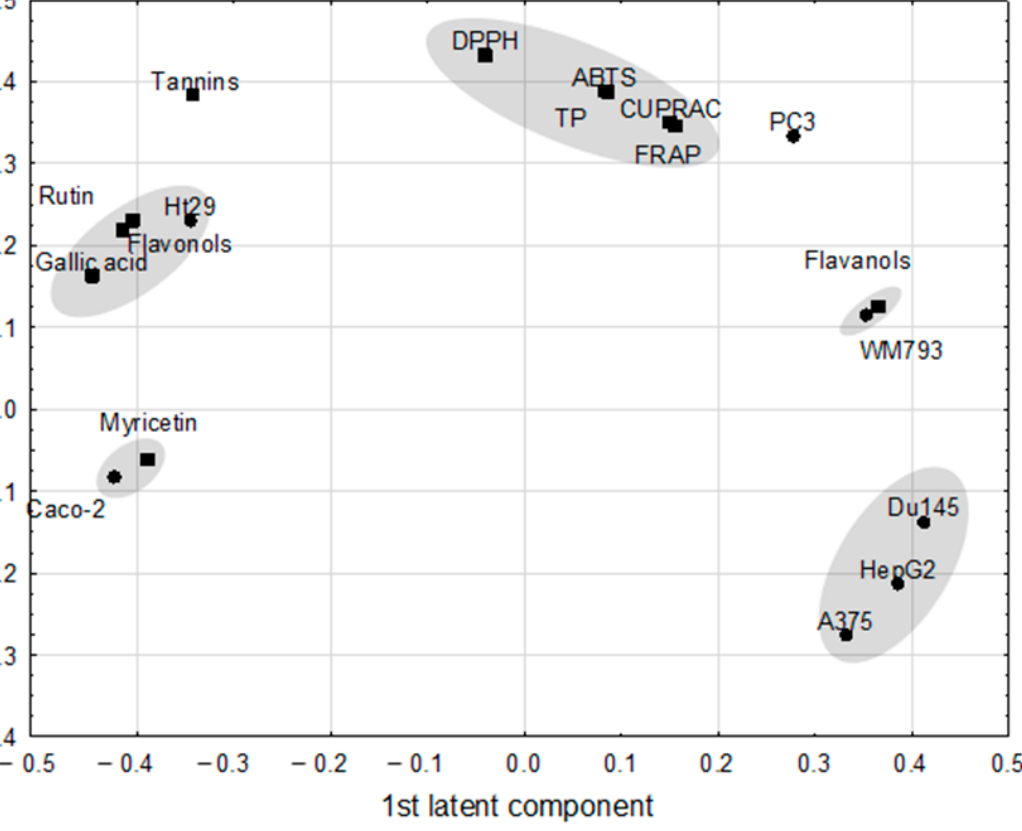
Table 3. Correlation weights for the pairs of parameters based on PLS model (only correlation weights with absolute values higher than 0.149 were shown).